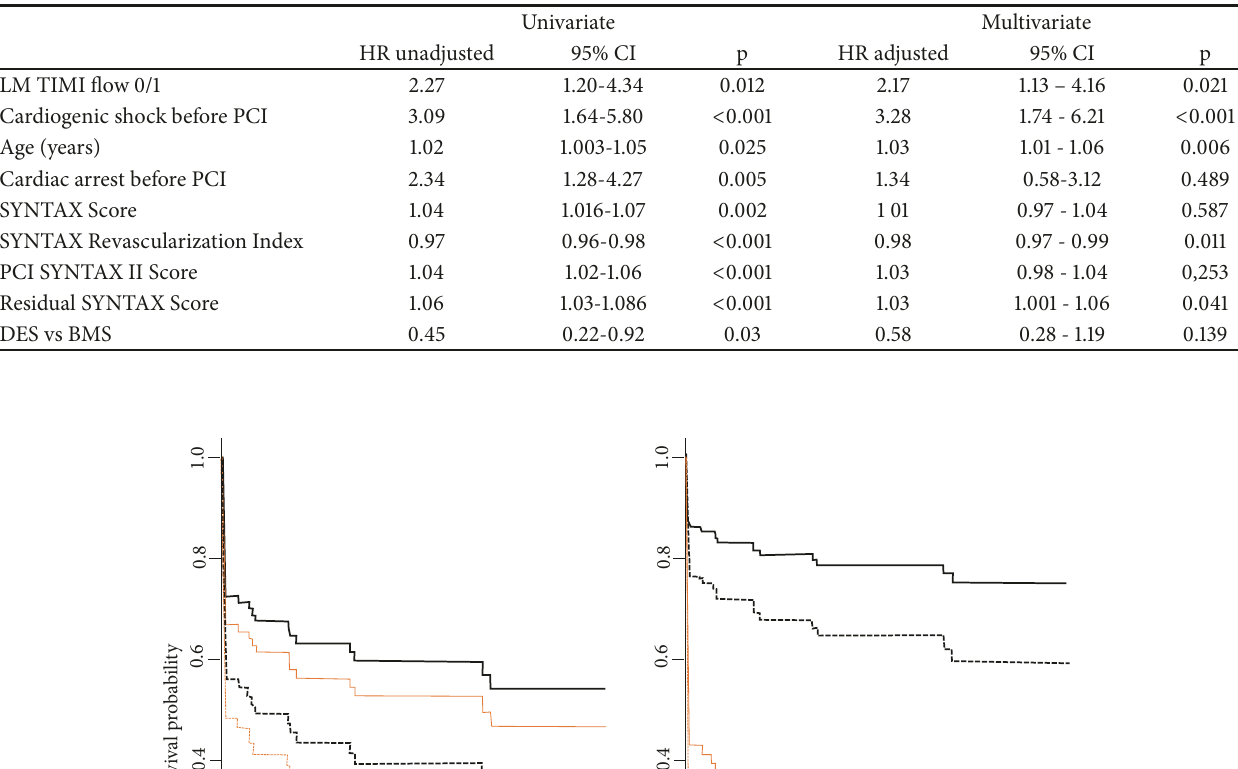
Table 6: Univariateand multivariateCox survival analyses adjusted for cardiogenic shock,initial TIMI flow, and age.BMS = bare-metalstent, DES = drug-eluting stent, LM = Left Main, PCI = percutaneous coronary intervention, and TIMI = Thrombolysis in Myocardial Infarction.